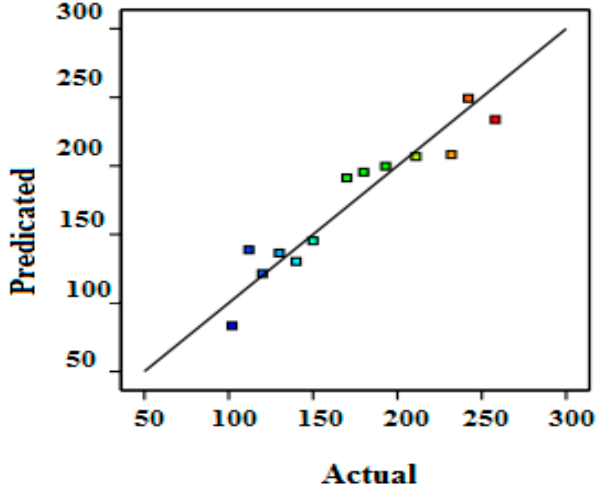
Figure 5. Comparison of the calculated and predicted values for permeate flux by RSM.